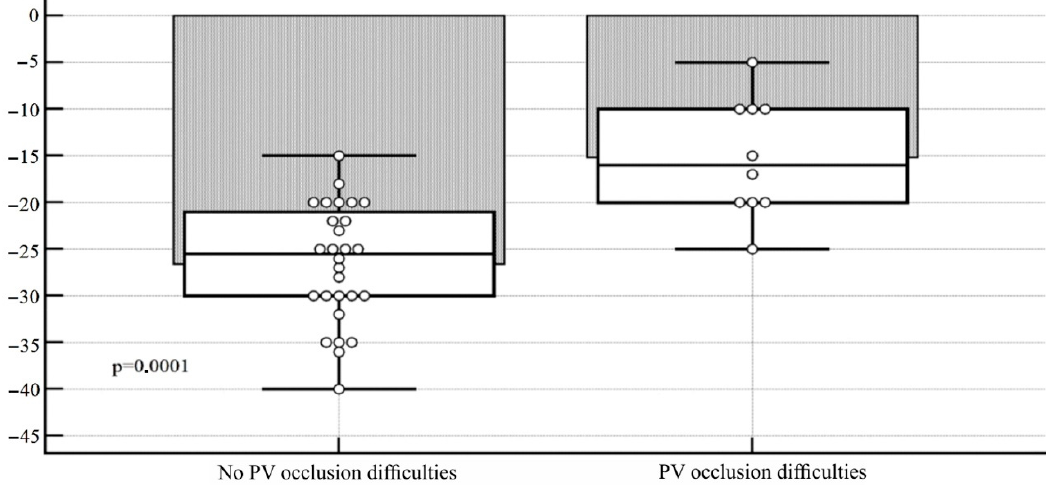
Figure 5. Diagram of angulation ranges of the RIPV in the frontal plane, depending on the pres- ence/absence of technical difficulties in positioning the cryoballoon in its ostium.